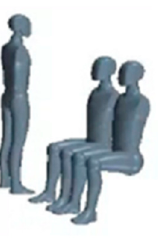
Figure 3. The body model.